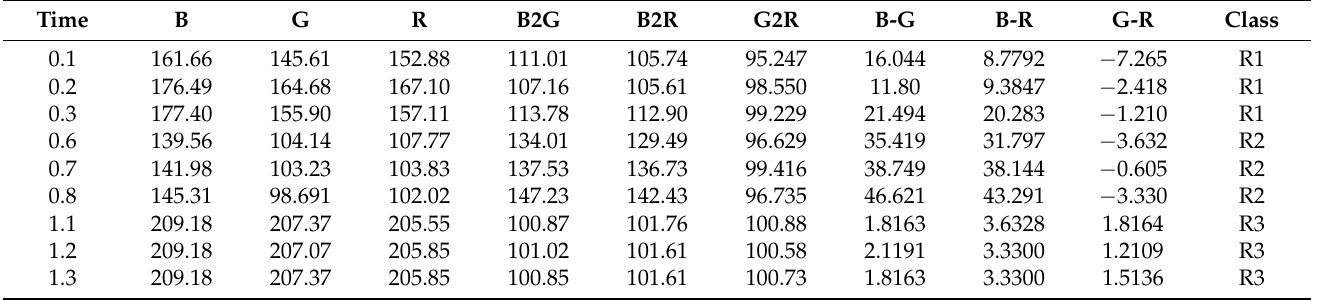
Table 6. Example for timestamped raw data acquired from the VLP unit and further extracted relative data in relation to the three different rooms R1 to R3